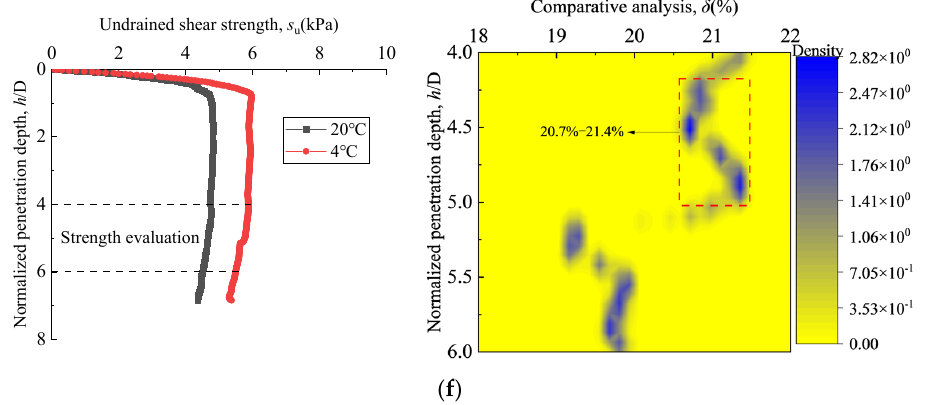
Figure 7. Undrained shear strength and difference in strength caused by temperature for six sediment segments at 20 °C and 4 °C: ( a ) 0–20 cm sediment segment S1; ( b ) 50–70 cm sediment segment S2; ( c ) 100–120 cm sediment segment S3; ( d ) 150–170 cm sediment segment S4; ( e ) 200–220 cm sediment segment S5; and ( f ) 250–270 cm sediment segment S6.